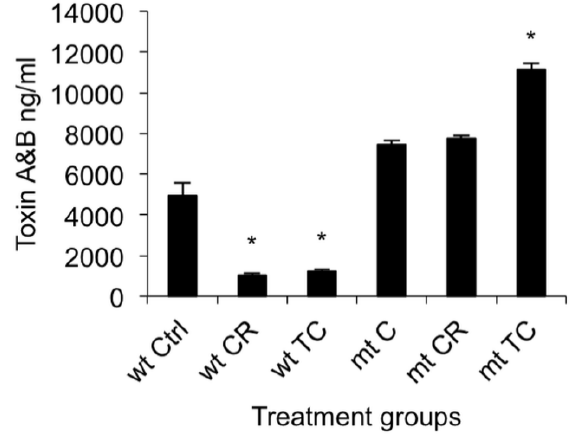
Figure 6. Effect of carvacrol (CR) and trans -cinnamaldehyde (TC) on codY mutant and